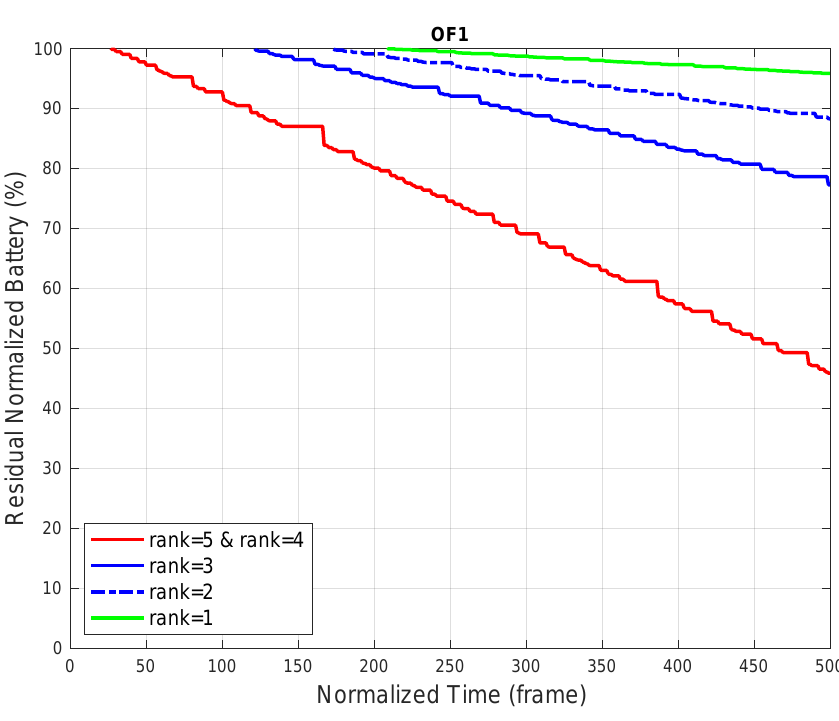
Figure 4. Residual normalized battery level time evolution of different groups of devices connected with RPL OF1.